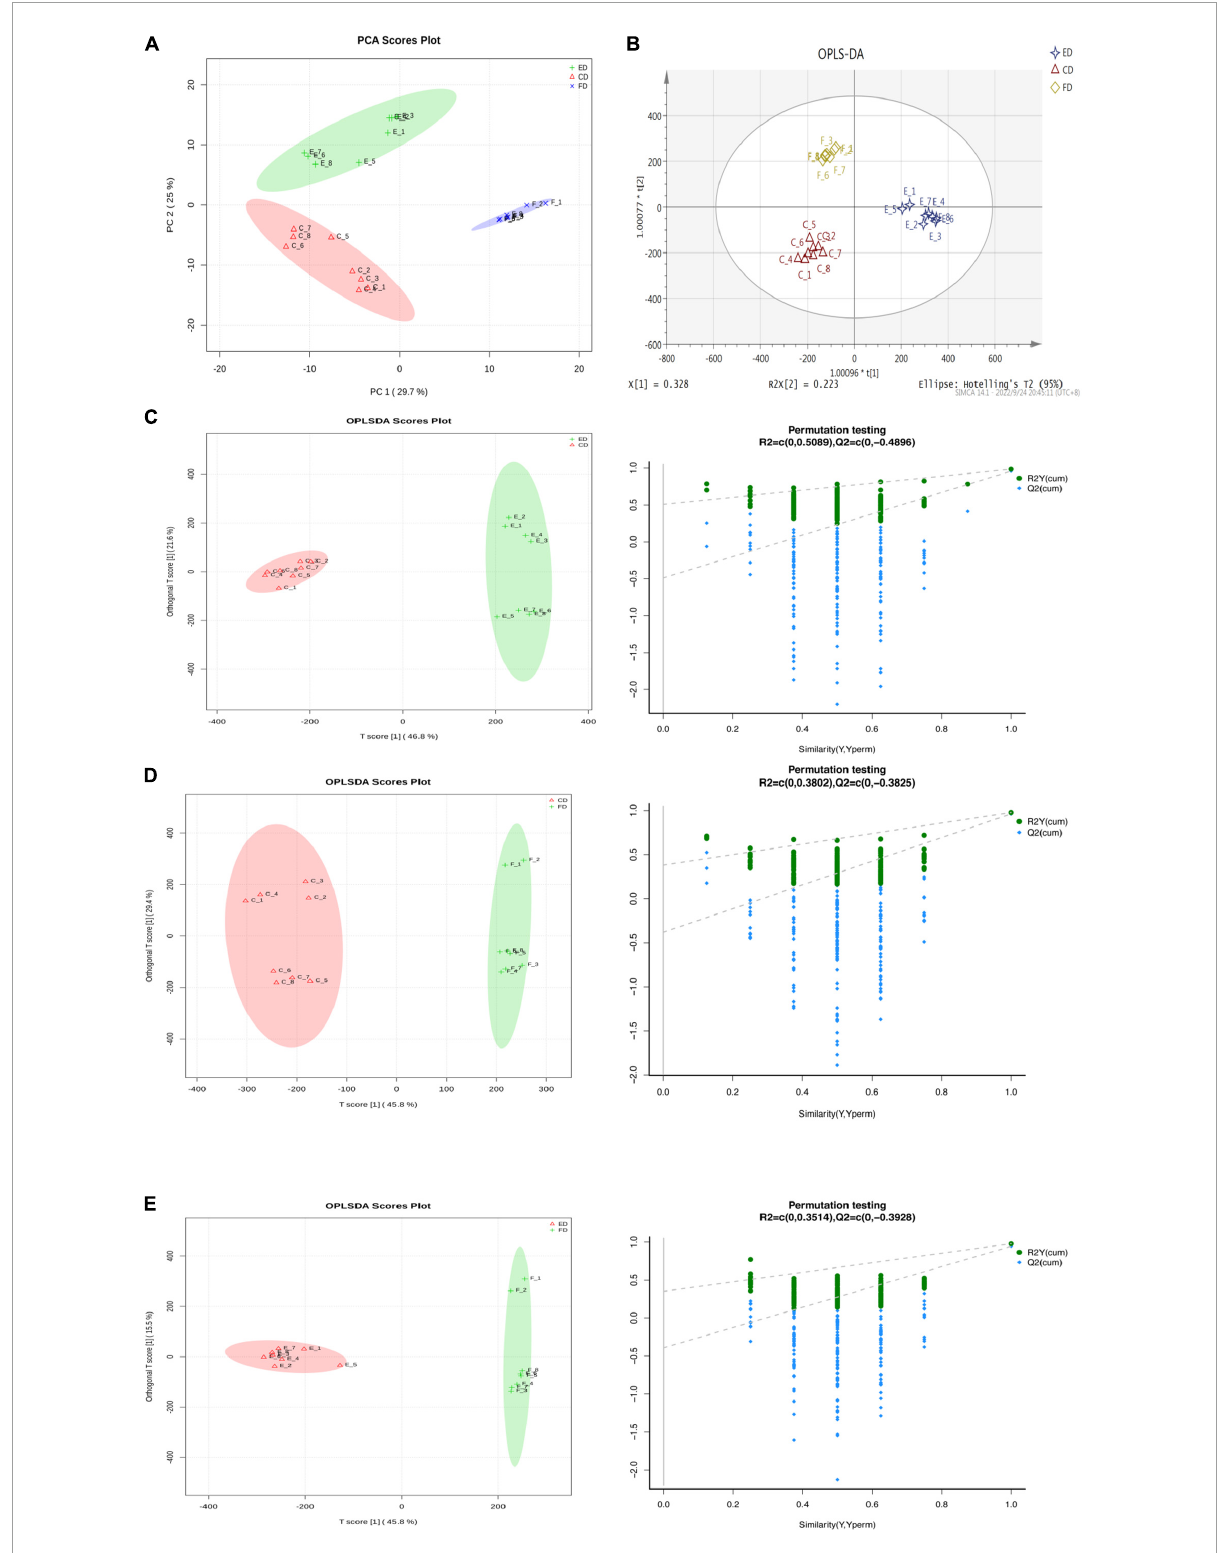
FIGURE1 Differential metabolite analysis in D. rubrovolvata samples processed by different drying methods. (A) PCA score plot of the three drying methods. (B) OPLS-DA score plot of the three drying methods. (C) OPLS-DA score plot and the permutation tests between CD and ED. (D) OPLS-DA score plot and the permutation tests between CD and FD. (E) OPLS-DA score plot and the permutation tests between FD and